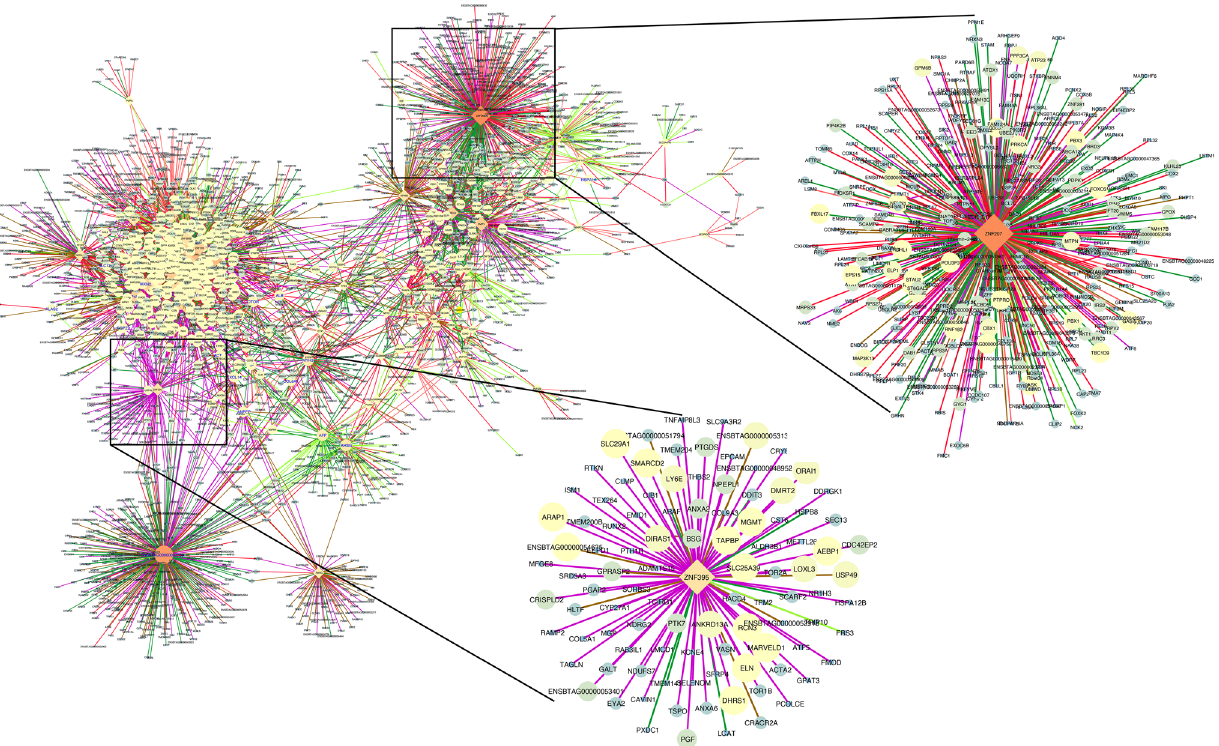
Figure 4. Cerebrum regulatory network of differentially co-expressed genes from the bovine transcriptome. Nodes are genes with significant changes in the correlation between control and nutrient restricted fetus ( q ≤ 0.05). The node size and color (from light to dark) are proportional to the number of connections for each gene. Nodes with few connections not linked to the main network are not showed. Only those gene pairs assigned as DEG, TS, or TF are shown. Transcription factors are represented by a diamond shape. Differentially expressed genes are labeled in blue. Edges are colored based on the differential correlation class (+/− , red; + /0, salmon; − /+ , green; − /− , deep sky blue; − /0, green-yellow; 0/+ , magenta; 0/− , brown). Gene network was created on Cytoscape v.3.7 89